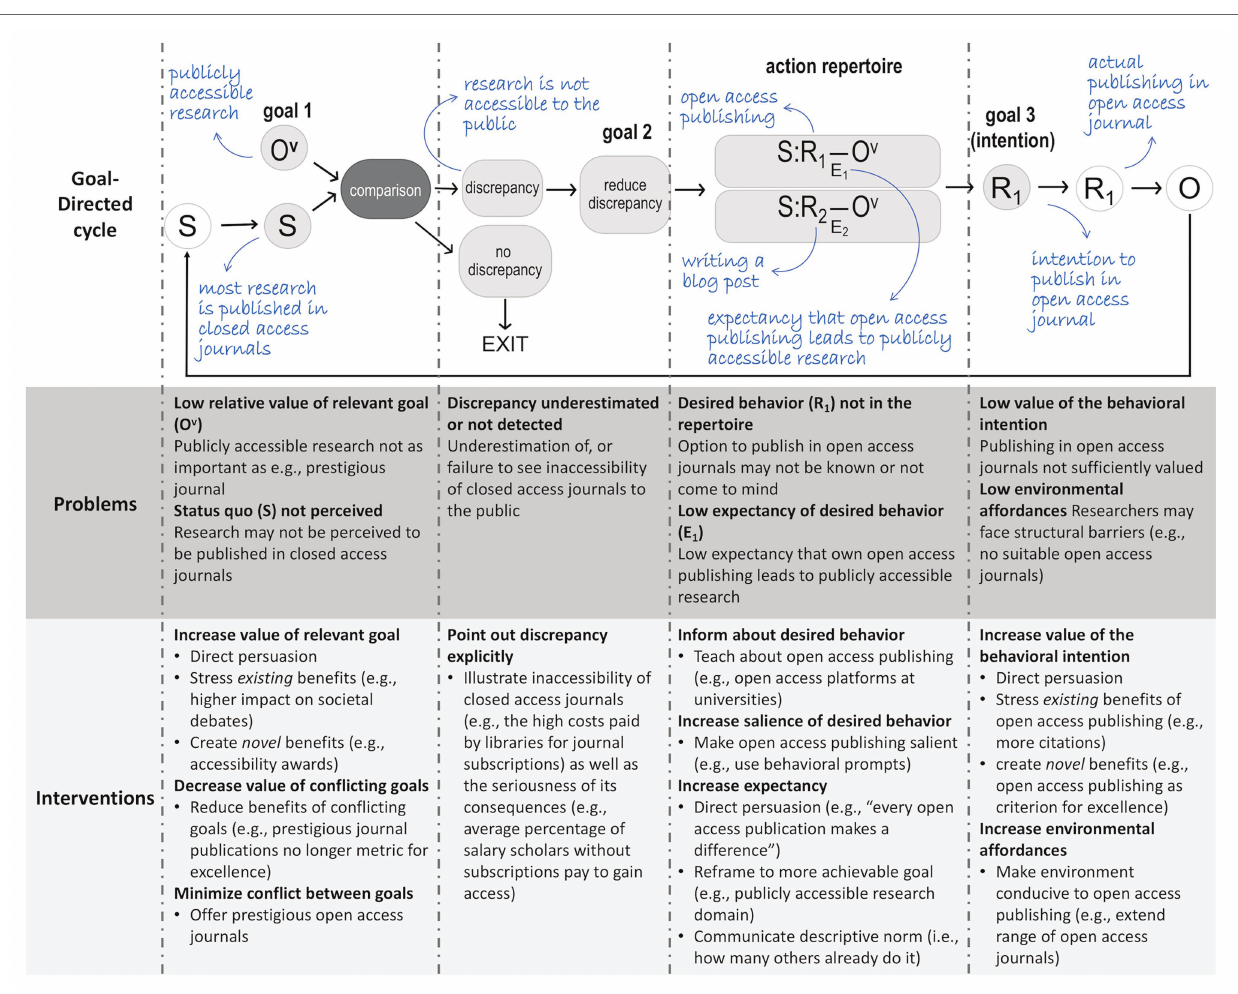
FIGURE 1 | The goal-directed cycle: problems and interventions in open access publishing. The general goal-directed cycle is depicted with white bubbles as observable factors; gray bubbles with black letters as mental representations; gray bubble with white letters as a mental operation. S, status quo (or stimulus); O v , valued outcome (V = value); O, actual outcome; E, expectancy; R, response or behavior. The application of the goal-directed cycle to open access publishing is depicted in blue handwriting. Problems and intervention strategies are located underneath the goal-directed cycle according to where they become relevant in the cycle. Figure adapted from Moors et al.